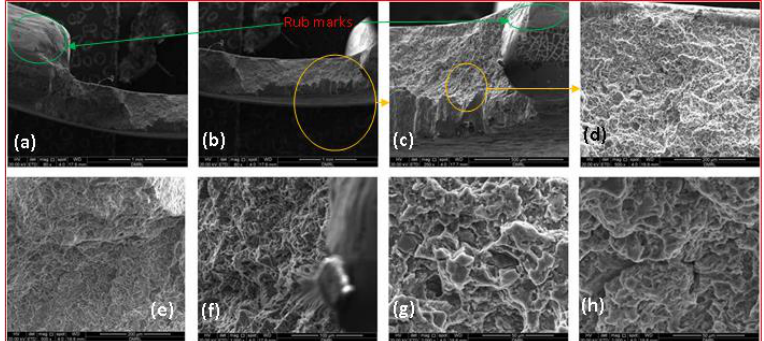
Figure 10: Fracture surface of connector 2 in different views, as seen under